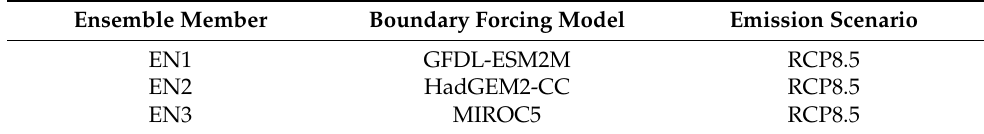
Table 3. Ensemble members